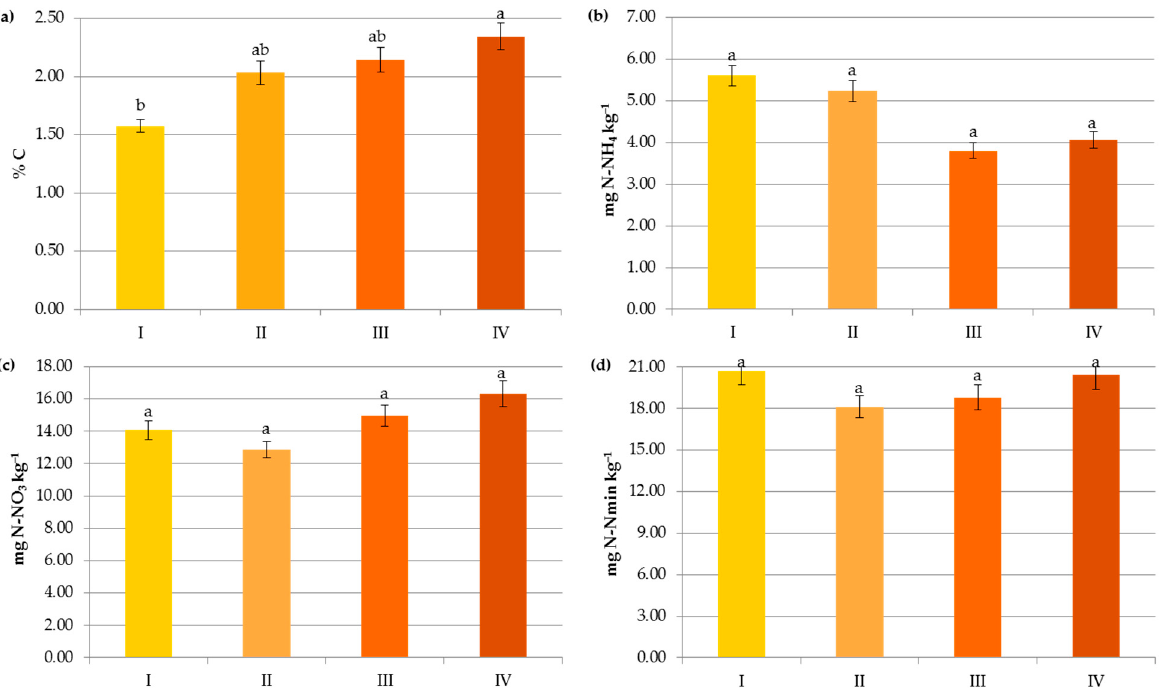
Figure 5. Impact of N manure application on contents of organic carbon ( a ), ammonium nitrogen ( b ), nitrate nitrogen ( c ) and mineral nitrogen ( d ): I—<50 kg N ha − 1 , II—50–100 kg N ha − 1 , III—100–150 kg N ha − 1 , IV—>150 kg N ha − 1 . The same letter means not significantly different.